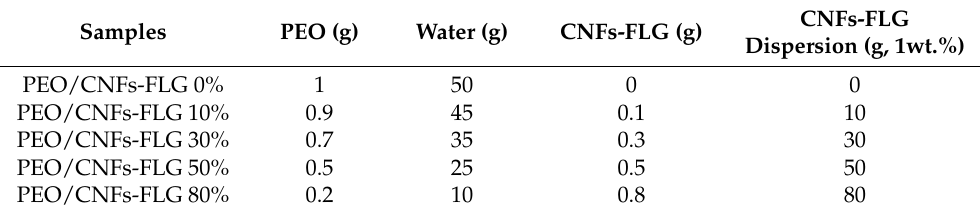
Table 1. Formulation of PEO/CNFs-FLG composites. Samples PEO (g) Water